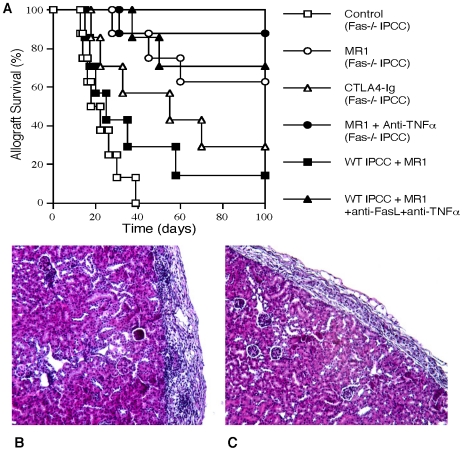
Blocking CD40-CD154 costimulation and Fas/TNF-receptor death pathways induces long-term IPCC allograft survival.IPCCs derived from B6.Fas-/- ASCs were transplanted to Balb/C recipients that were untreated (Open square, n = 8) or treated with MR1 (Open circle, n = 8), CTLA4-Ig (Open triangle, n = 7) or both MR1 and anti-TNFα Ab (Filled circle, n = 8). As a control, WT.B6-derived IPCCs also were transplanted to Balb/C recipients that were treated with MR1 alone (Filled square, n = 7) or MR1 + anti-FasL + anti- TNFα to block both CD154 costimulation and death pathways (Filled triangle, n = 7). IPCC allograft survival was observed (A). H&E staining of kidneys harboring Fas-/- IPCC allografts derived from an untreated control (B) or MR1+anti-TNF treated recipient (C) was performed two weeks after IPCC transplantation. (Magnification ×100).